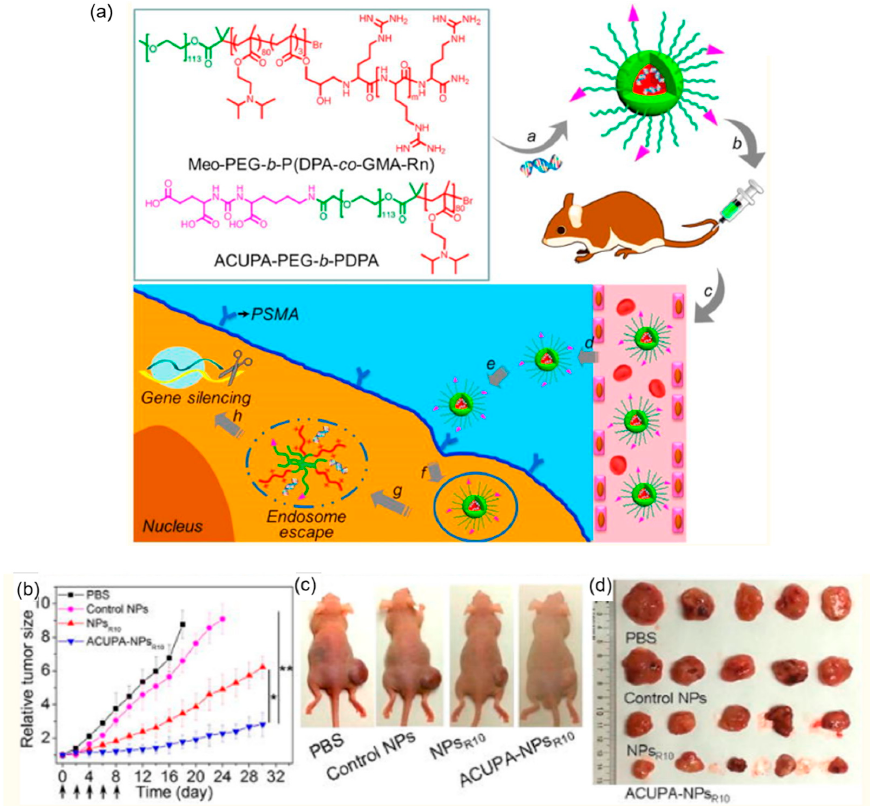
Figure 15. A pH-responsive nanoparticle (NP) platform for cancer-specific in vivo siRNA delivery. ( a ) Molecular structures of the oligoarginine functionalized sharp pH-responsive polymer